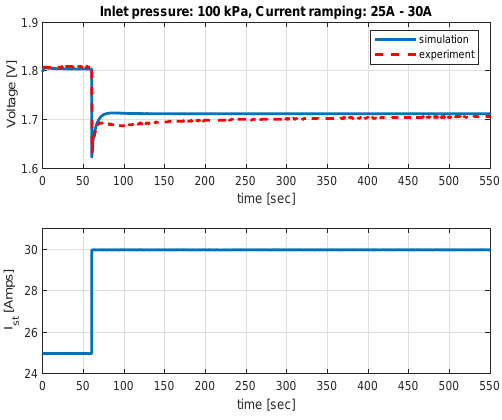
Figure 9. Transient response the PEMFC control-oriented nonlinear